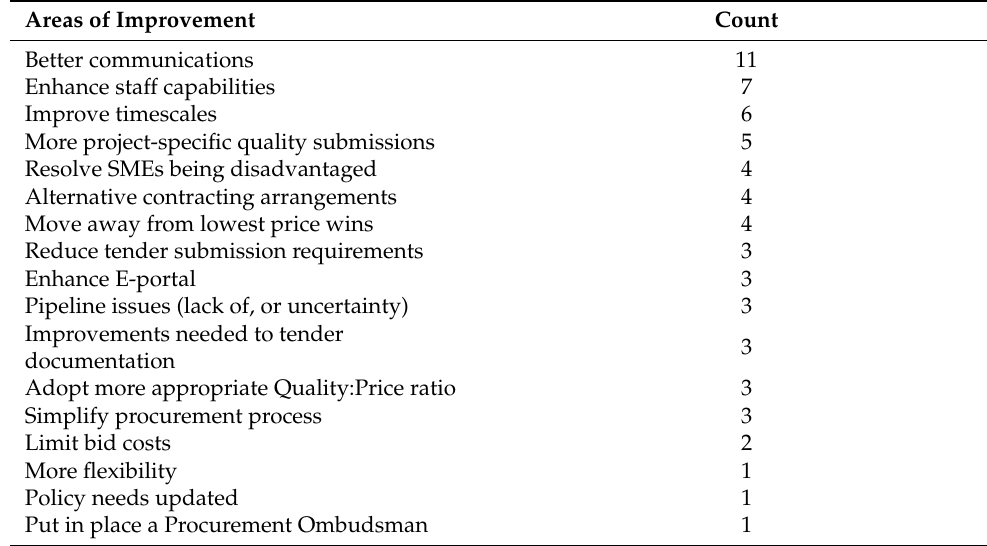
Table 12. Thematic analysis of suggested areas of